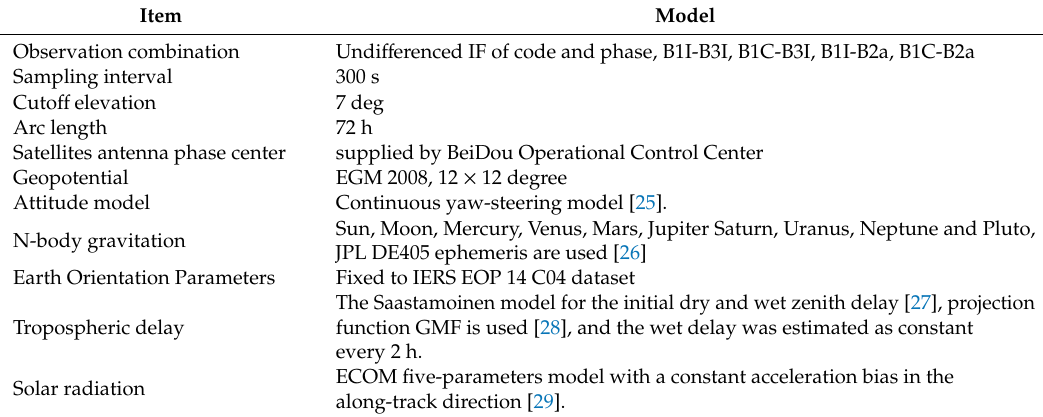
Table 3. The observation models and force models used in precise orbit determination